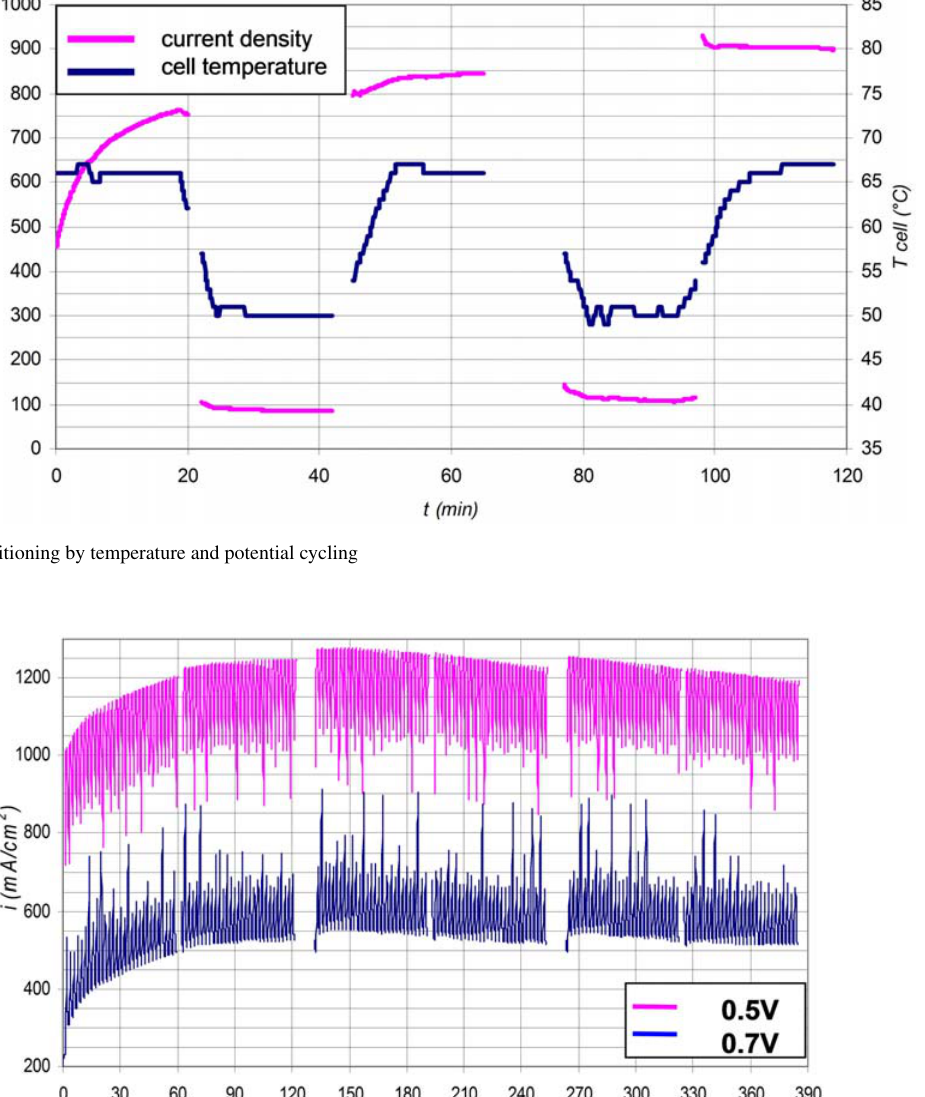
Fig. 2. Potential cycling is known to accelerate initial con- ditioning while increasing the frequency of cycling redu- ces the activation time even more. 2